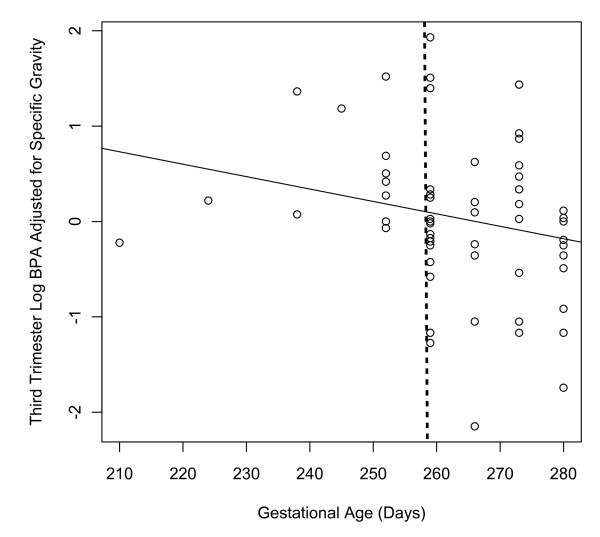
Relationship between gestational length and log transformed third trimester urinary bisphenol-A concentrations among Mexican women (N = 60). The dotted line represents the 259 day (37 week) of gestation cutoff for preterm delivery.